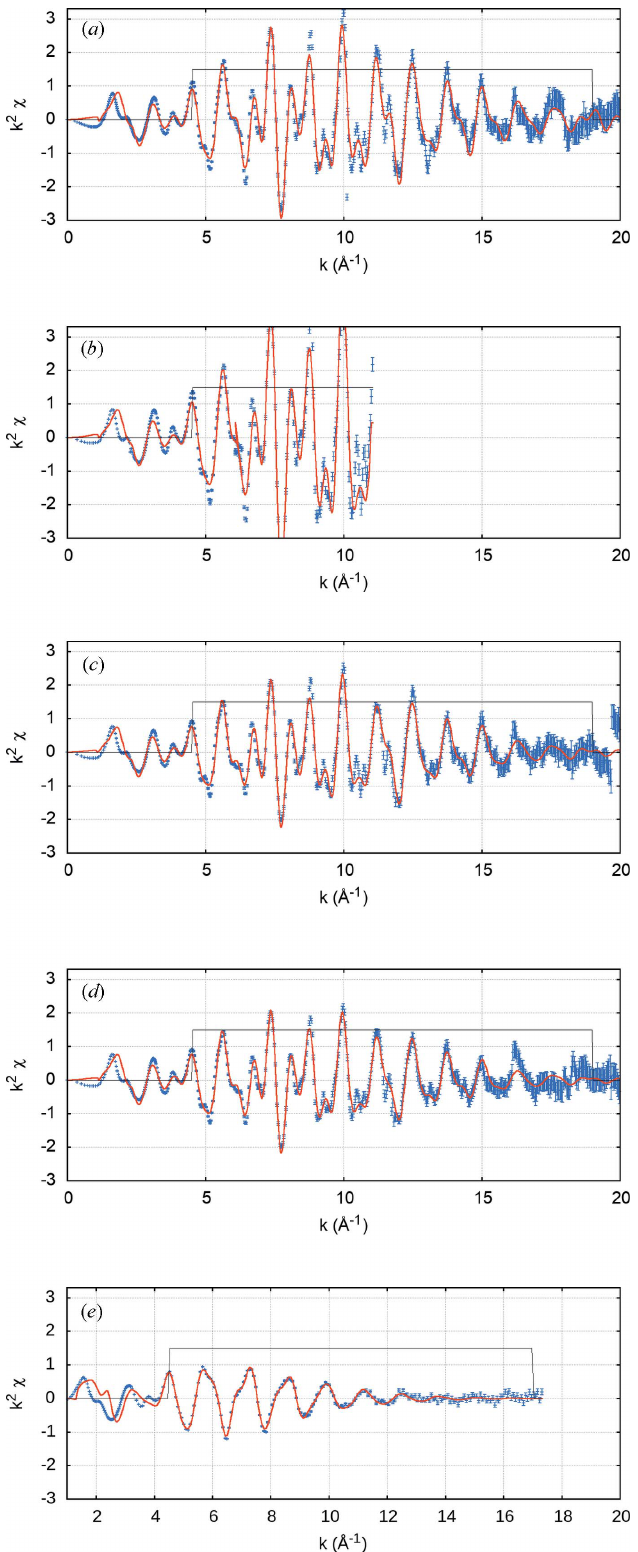
Figure 13 Results of eFEFFit modelling at ( a ) 10 K, ( b ) 50 K, ( c ) 100 K, ( d ) 150 K, ( e ) 298 K using initial geometry from Nuss et al. (2010). The FEFF fits match the structure very well across a large k -range and also in the lower k -range. At increasing temperature, the oscillations are of smaller magnitude and less detailed.